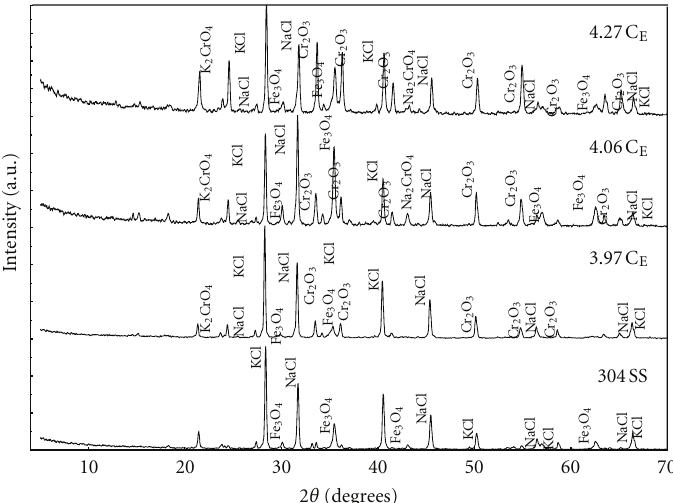
Figure 5: X-ray patterns of corrosion products formed on cast irons containing 4.27, 4.06, 3.97 C E and on 304-type stainless steel exposed to NaCl-KCl at 670 ◦ C during